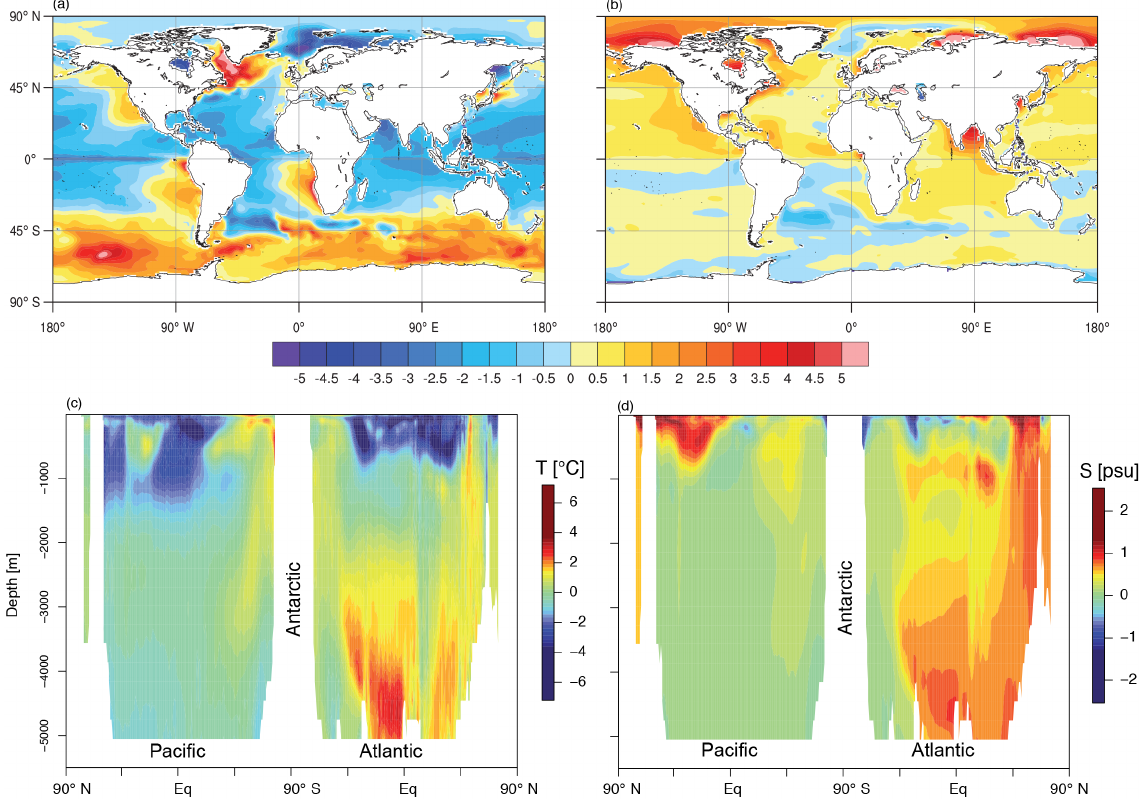
Figure 6. Annual bias patterns of simulated temperature T and salinity S averaged over 1986–2005 compared to the WOA2013 observations (Levitus et al., 2013). Surface biases for sea surface temperature (a) and salinity (b) are represented using the same color bar. Vertical structure of biases for temperature (c) and salinity (d) are estimated using zonal-average biases from WOA2013 across the Atlantic and Pacific